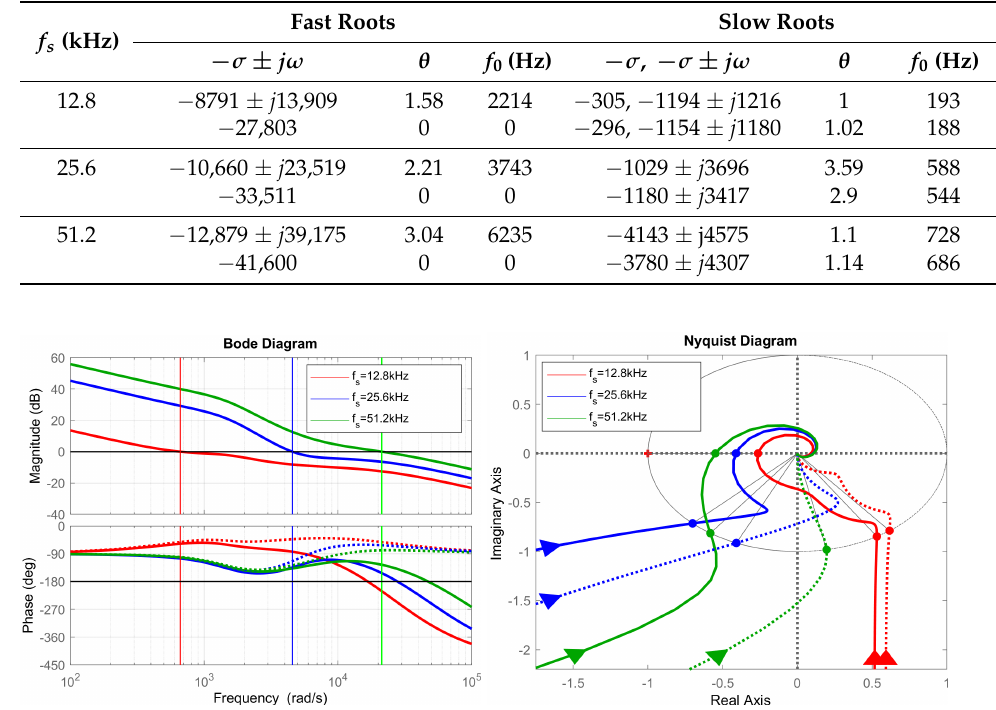
Figure 18. Bode and Nyquist plots for the load mode. Large stability margins ∆ A and ∆ φ are to be noticed. f s = 12.8 kHz: ∆ φ = 122 deg, f 1 = 106 Hz, ∆ A = 3.79, f π = 2658 Hz; f s = 25.6 kHz: ∆ φ = 45 deg, f = 727 Hz, ∆ A = 2.44, f π = 4440 Hz; f s = 51.2 kHz: ∆ φ = 54 deg, f 1 ∆ A = 1.82, f π = 7512